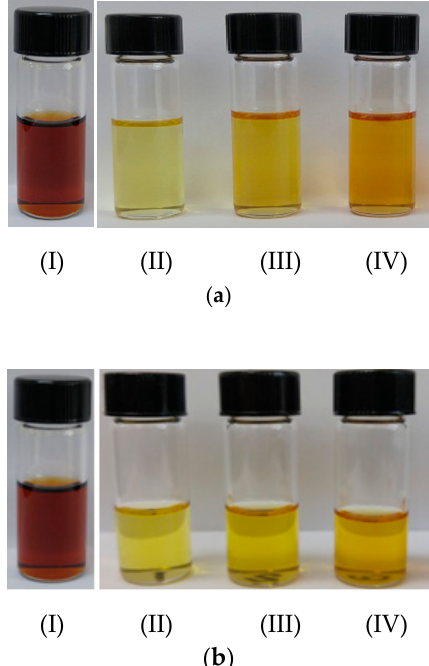
Figure 3. Comparison of solvent for color change in raffinate according to y w,0 . Solvent used: ( a ) DMF, ( b ) DMSO. Experimental condition: t = 72 h, (S/F) 0 = 3, T 0 = 28 °C. (I) raw material, (II) y w,0 = 0, (III) y w,0 = 0.03, and (IV) y w,0 = 0.06.